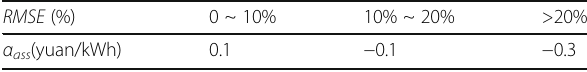
Table 2 Coefficients of the assessment rewards or